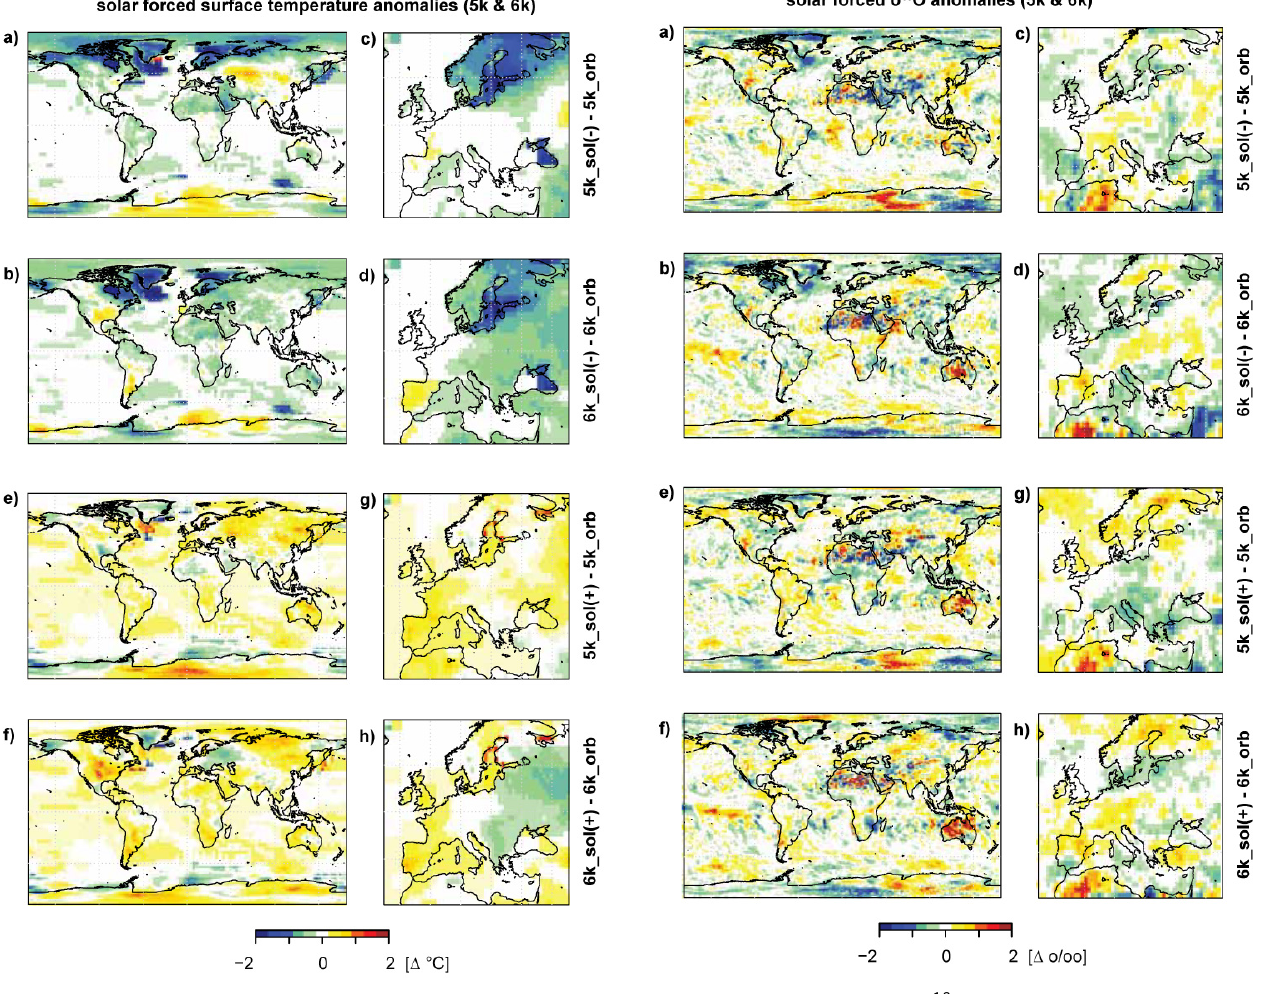
Fig. 6. Simulated solar activity-induced changes of mid-Holocene (5k, 6k) surface temperatures. The temperature anomalies are cal- culated between the experiment with additional solar influence boundary conditions (sol( − ) and sol( + ), respectively) and the undisturbed 5k and 6k climate simulations. Results for low solar activity forcing are shown in panels (a–d) , and for high solar activ- ity in panels (e–f) . Plot details are similar to Fig. 2.